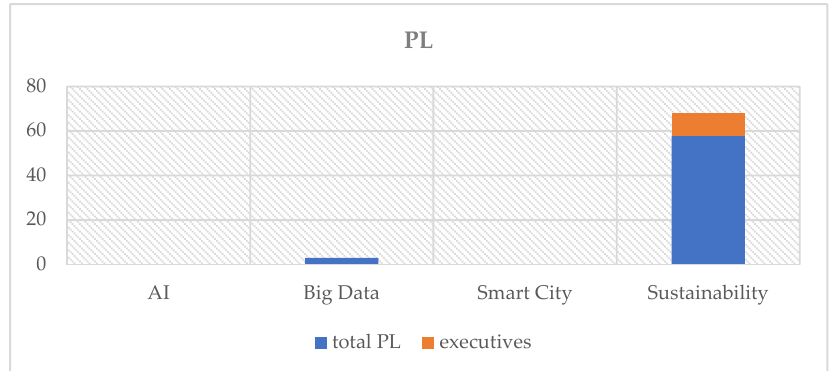
number and the number of job posts for executives.